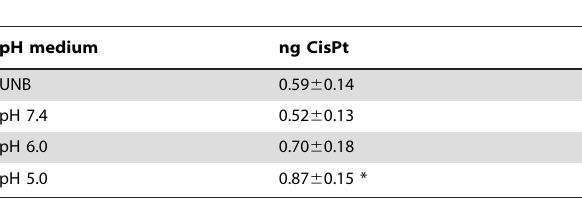
Table 1. Content of CisPt in the